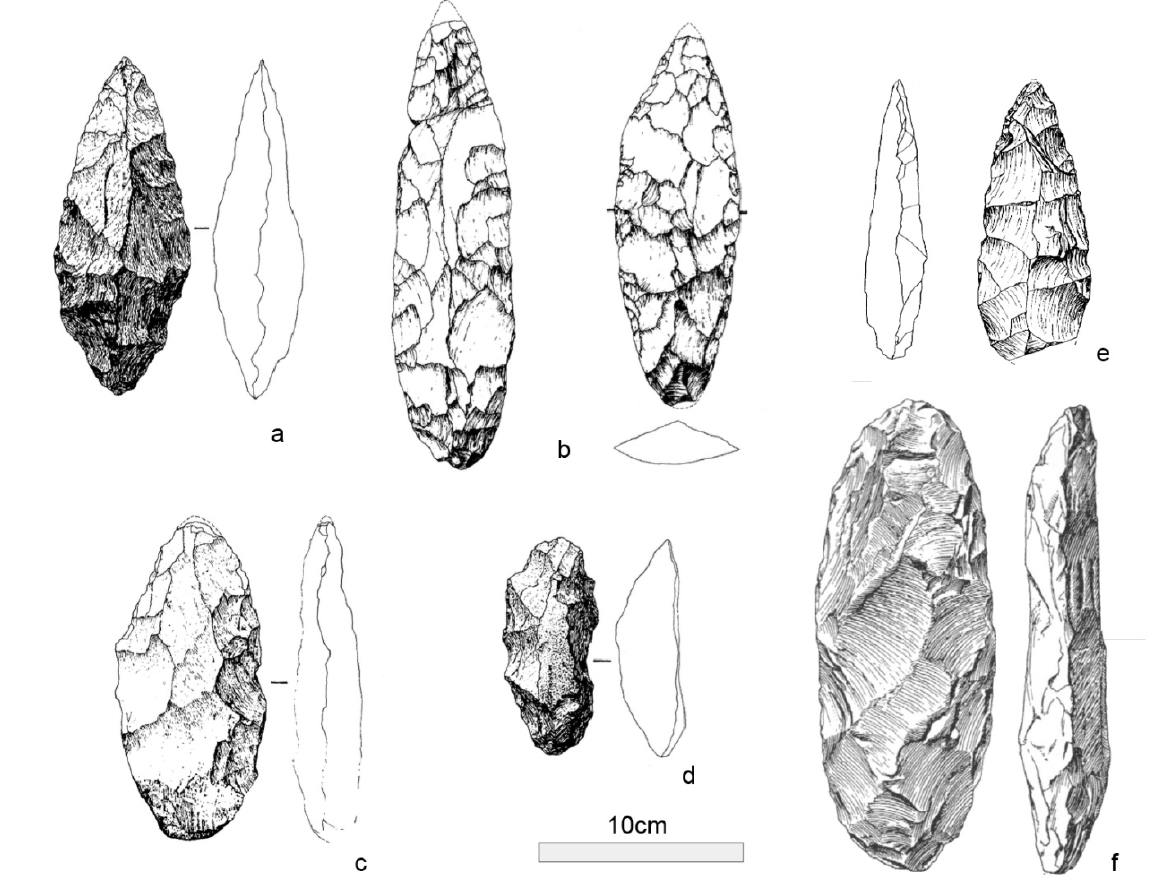
Figure 1. Examples of bifacial shaped tools attributed to Lupemban or Sangoan-Lupemban; a,b,c,d: from Muguruk (Kenya) (McBrearty 1985), e: from Mosumu (Equatorial Guinea) (Mercader 2002), f: from Nsongezi (Uganda) (O’Brien 1939). a, b and e are identified as Lupemban